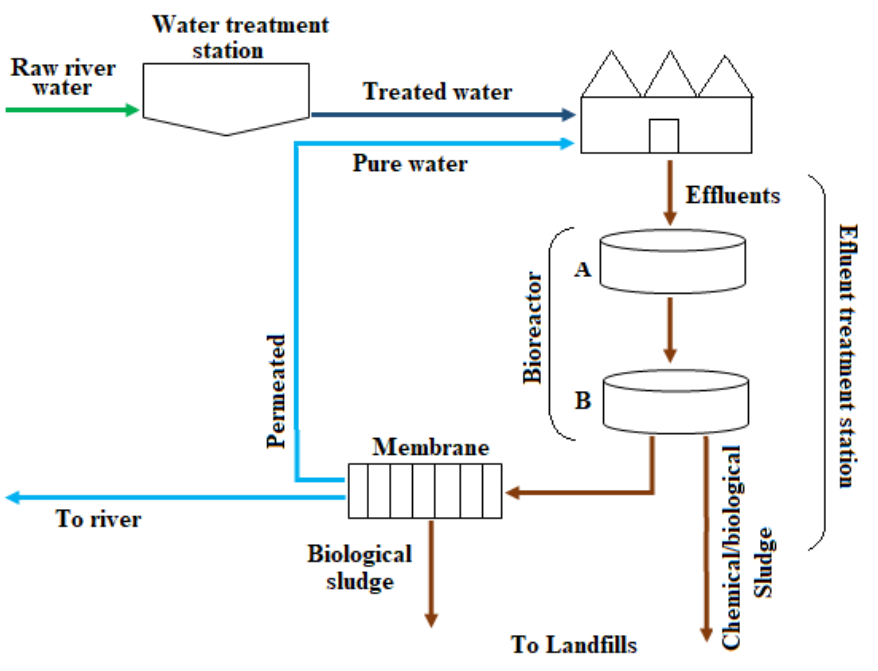
Figure 2. Process of the water cycle of the cosmetics company. Source: Company data.